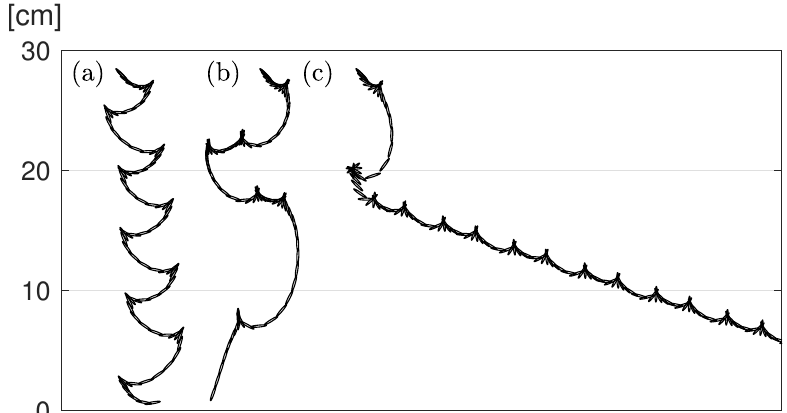
Figure 8. Falling trajectory and orientation of ellipse. ( a ) Fluttering, ( b ) chaotic falling, ( c ) tumbling.